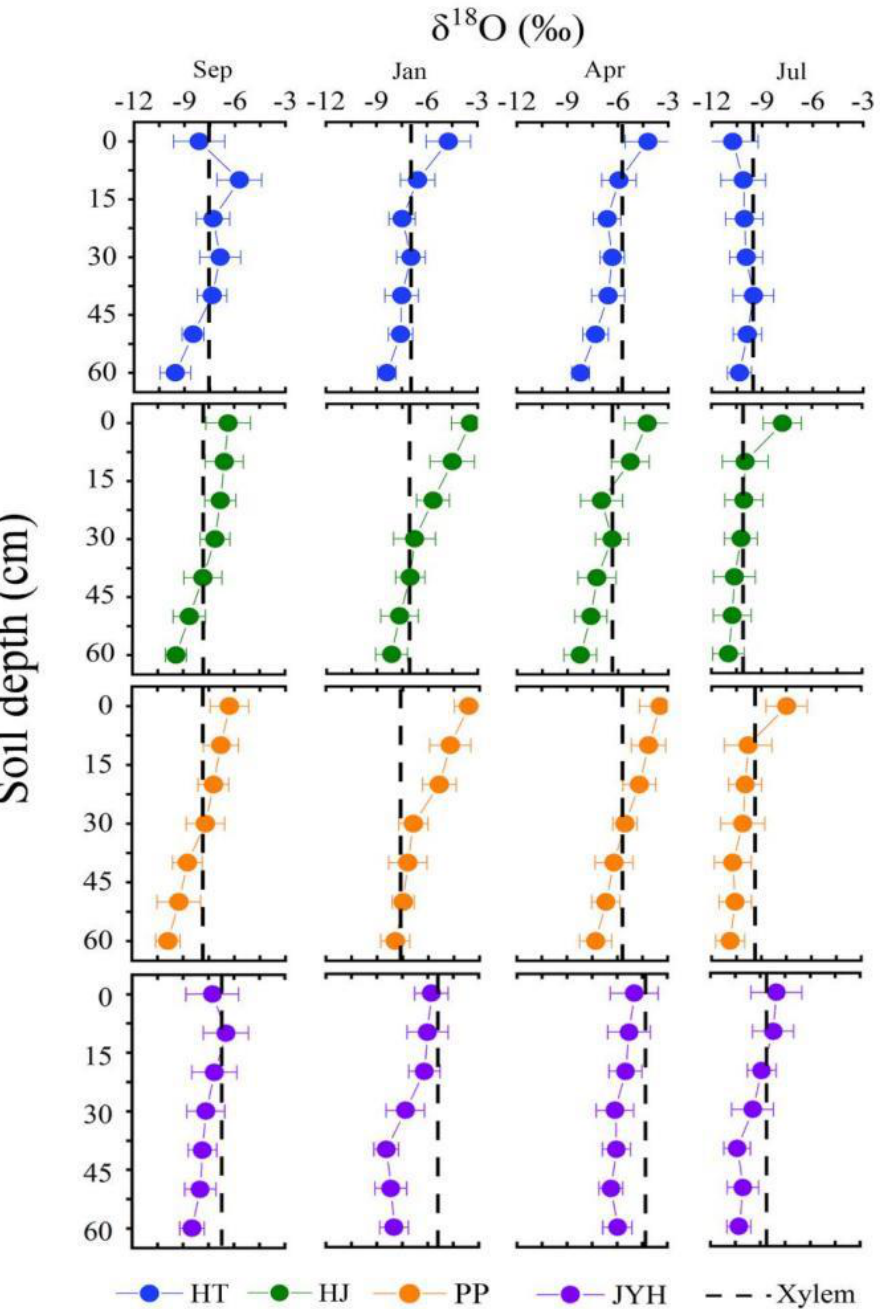
Figure 7. Seasonal variation in δ 18 O in soil layer (0–60 cm) and xylem water (vertical dashed line) of four species. From left to right are September 2021, and January, April, and July 2022. Error bars represent standard deviations ( p < 0.05).